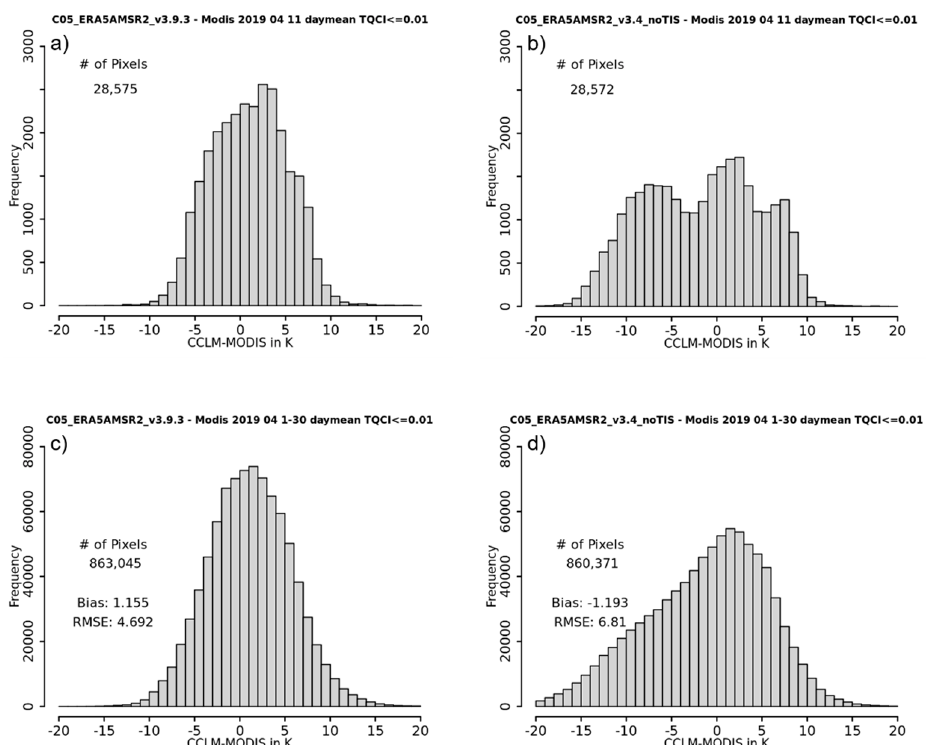
Figure 8. Frequency distributions of differences between the surface temperature over sea ice areas of CCLM and MODIS for ( a / c ) 11 April 2019/whole April 2019 for the new version, ( b / d ) 11 April 2019/whole April 2019 for the old version after cloud filtering (see text) .